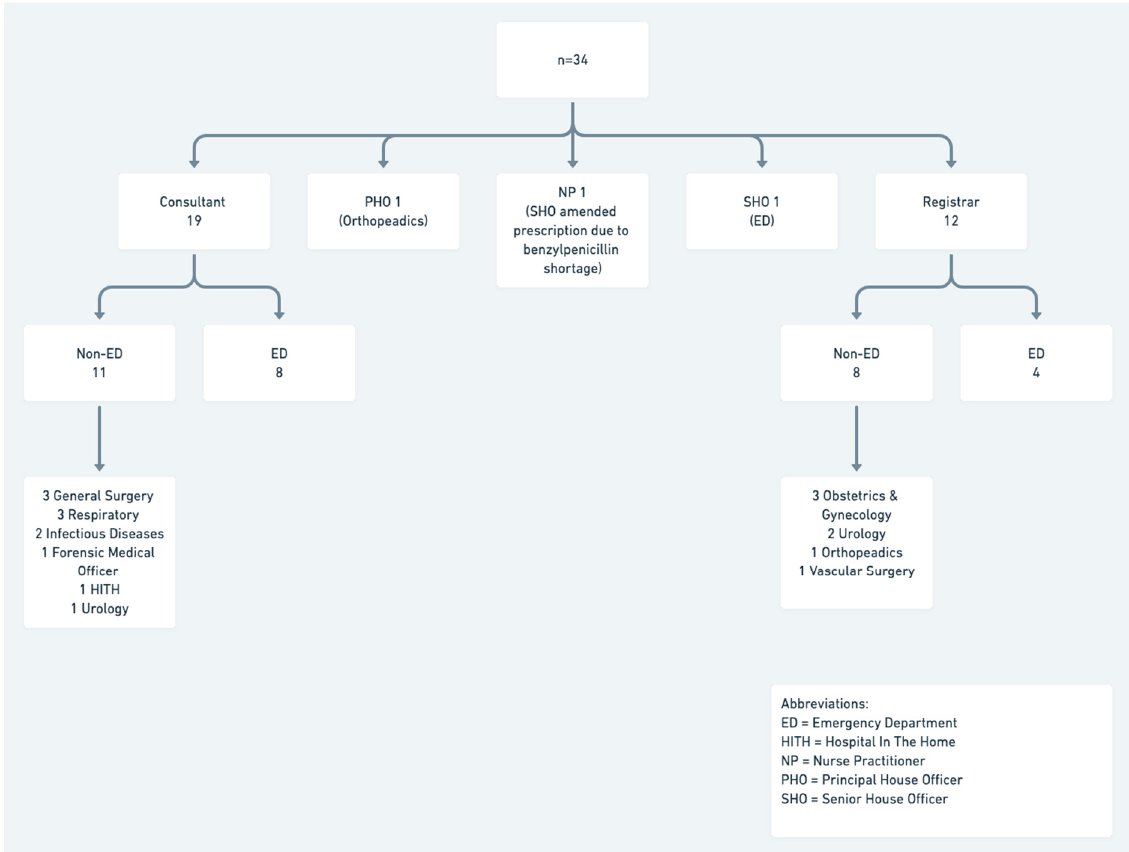
Figure 2. Antibiotic prescribing guided by other staff than prescriber ( n = 34).